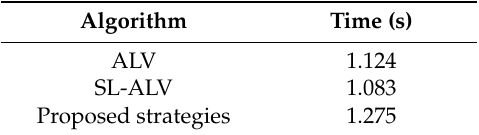
Table 3. Average time required to calculate a homing